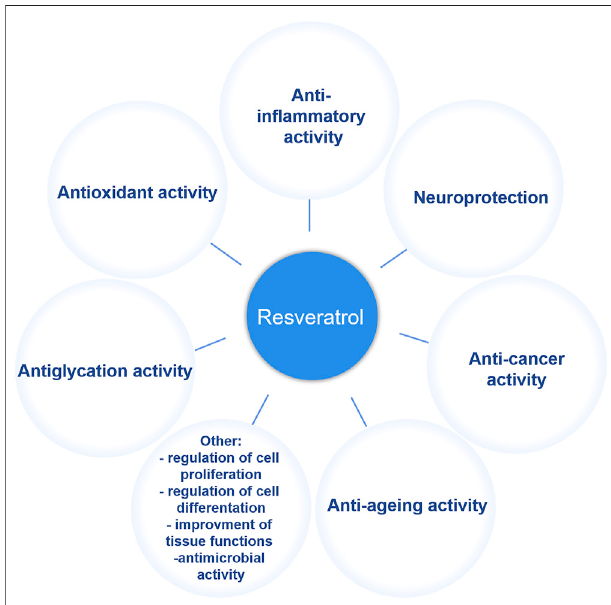
FIGURE 1 | Physiological function of